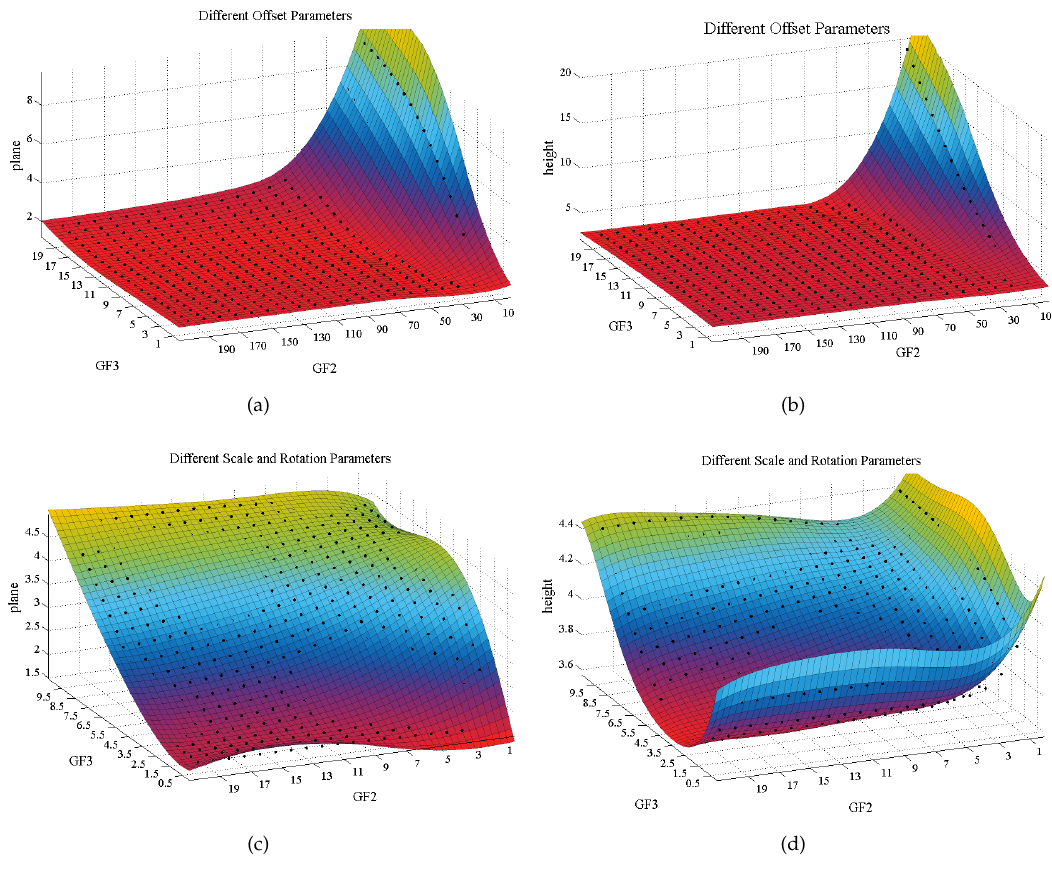
Figure 8. Geometric accuracy analysis of GF2 and GF3 combined geopositioning: ( a ) plane geometric accuracy analysis with different offset parameters, ( b ) altitude geometric accuracy analysis with different offset parameters, ( c ) plane geometric accuracy analysis with different scale and rotation parameters, and ( d ) altitude geometric accuracy analysis with different scale and rotation